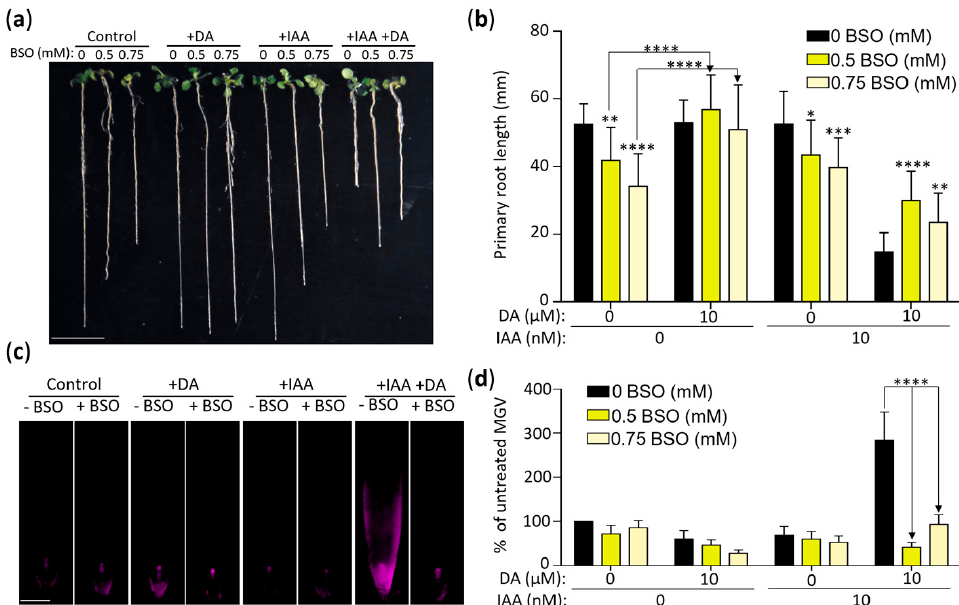
Figure 7. DA-induced auxin sensitivity is modulated by buthionine sulfoxamine (BSO). ( a ) Inhibition of GSH biosynthesis alters the impact of DA on root growth and auxin sensitivity. Col-0 seedlings grown vertically on MS/2 media supplemented with the denoted concentrations of BSO, DA (+DA, 10 µ M), and IAA (+IAA, 10 nM) for 11 days were arranged and photographed. Scale: 10 mm. ( b ) Quantification of the inhibitory effect of BSO on DA-induced IAA hypersensitivity. Seedlings were grown as described in ( a ) and were photographed, and rosette diameter was measured using ImageJ software. Data are presented as mean ± SD ( n ≥ 21; **** represents p < 0.0001; *** represents p < 0.001; ** represents p < 0.01; * represents p < 0.05; two-way ANOVA with Tukey’s post-test; stars without arrows are BSO treatments compared to the control; other comparisons are demarked by one-way arrows). ( c ) DR5::RFP expression confirms that BSO reduces DA-induced IAA hypersensitivity. DR5::RFP seedlings were grown for 7 days on the denoted concentrations of BSO, DA (+DA, 10 µ M), and IAA (+IAA, 10 nM), and RFP fluorescence was captured using fluorescent microscopy. Scale: 100 µ m. ( d ) Quantitative analysis of DR5::RFP signal described in ( c ). Root tissue was traced 600 µ m from the root cap, and mean grey value (MGV) was calculated using ImageJ software. Data are presented as percent of the control MGV ± SEM ( n ≥ 16; **** represents p < 0.0001; two-way ANOVA with Tukey’s post-test; multiple comparisons demarked by one-way arrows).